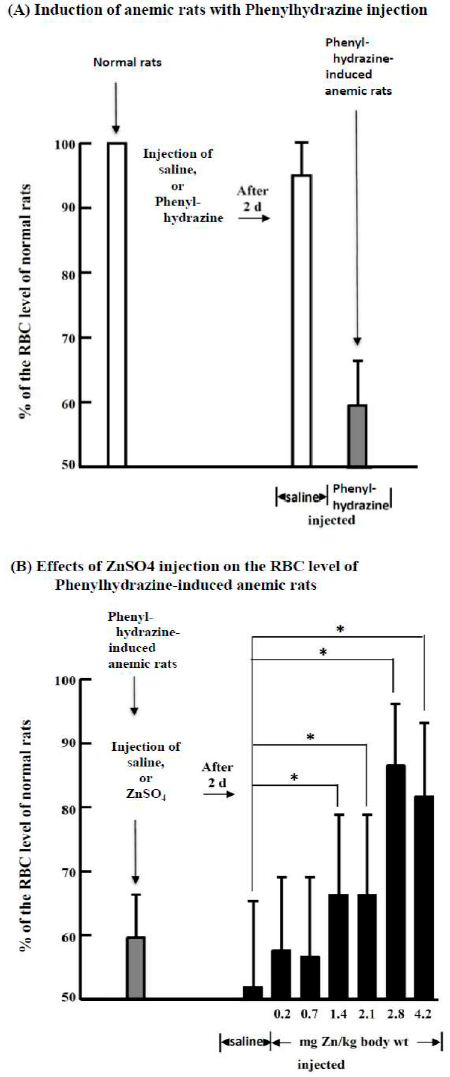
Figure 1. Induction of anemic rats by treatment with phenylhydrazine hydrochloride (PHZ) and the effects of ZnSO 4 on their RBC levels. ( A ) Normal rats were injected with saline or a single PHZ (60 mg/kg body weight) solution at day 0; ( B ) After two days, the PHZ-induced anemic rats were further injected with saline or different concentrations of ZnSO 4 solution. After another two days (at day 4), the rats were sacrificed, and RBC levels and other hematological indices were measured. *, significant difference between ZnSO 4 -injected and saline-injected anemic rats ( p < 0.05, n = 6). This figure is representative of three different